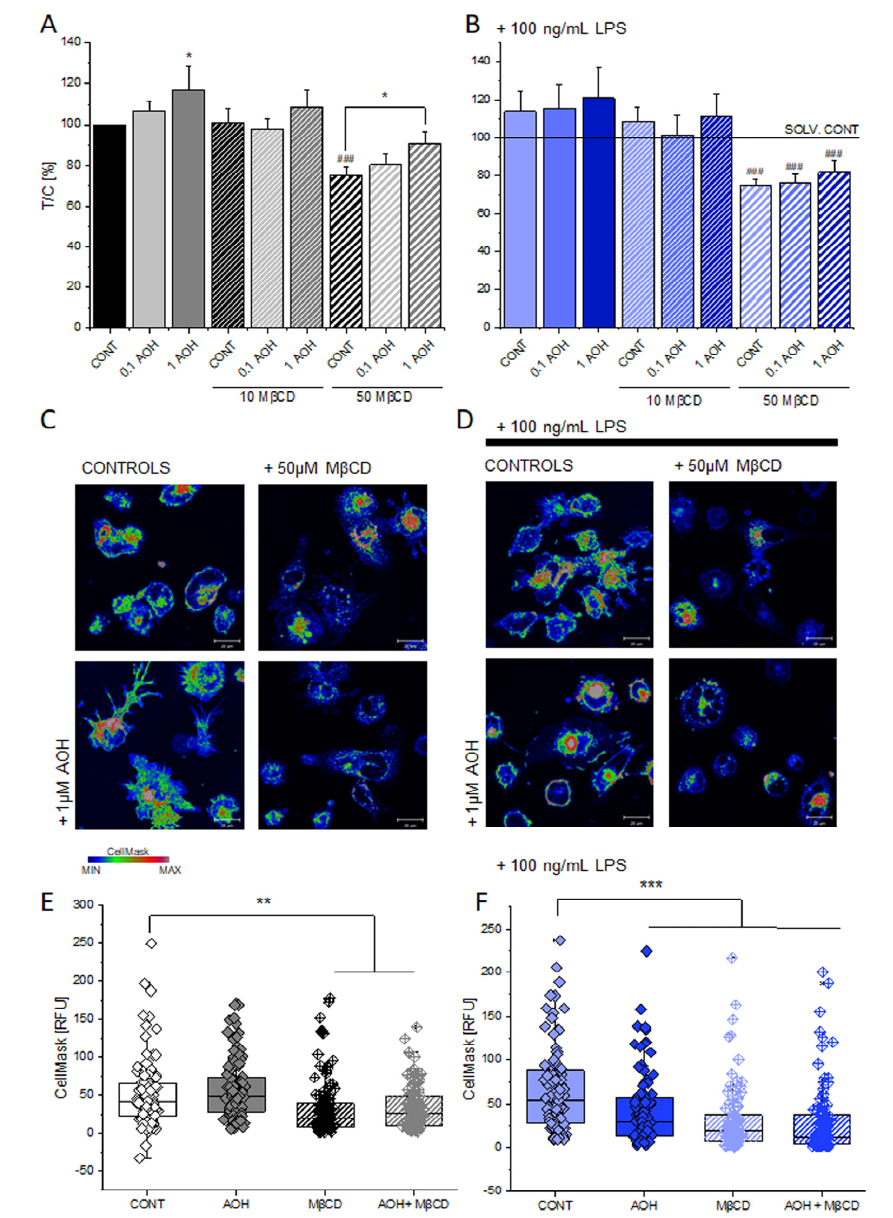
Figure 2. E ff ect of AOH (0.1–1 µ M) and M β CD (10–50 µ M) on the membrane fluidity of THP-1 macrophages at indicated conditions ( A ) and in additional presence of 100 ng / mL LPS ( B ). Data are mean ± SEM of eight independent experiments performed in triplicate. ### ( p < 0.001) identifies significant decrease, according to the ANOVA test with Fisher test in comparison to controls. The appearance of the membrane of THP-1 macrophages ( C , D ) after 1 h incubation with the compounds of interest and staining with CellMask for cell membrane. Scale bar: 20 µ m. Quantification of fluorescence intensity of the cell membrane staining (RFU, Relative Fluorescence Units; 1 µ M AOH, 50 µ M M β CD or 1 µ M AOH + 50 µ M M β CD; ( E , F )). Data are obtained from the quantification of n ≥ 80 cells from four independent experiments and ** and *** indicate significant di ff erence in comparison to controls with p < 0.01 and p < 0.001 with Student’s t